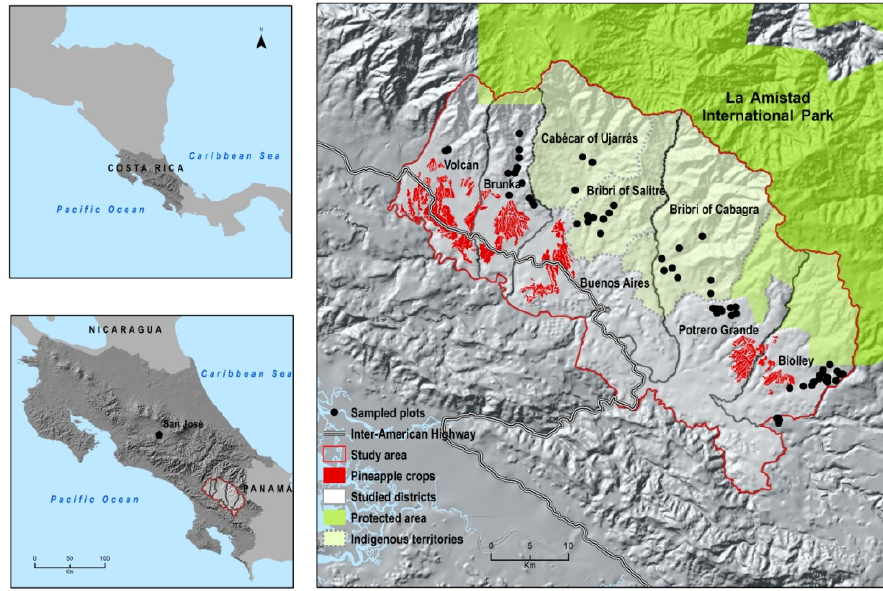
Figure 1. Location of the study area, the plots sampled and the distribution of the pineapple crops. Source: generated by the authors based on the cartographic distribution of pineapple crops [41] and the Costa Rica Atlas [42].